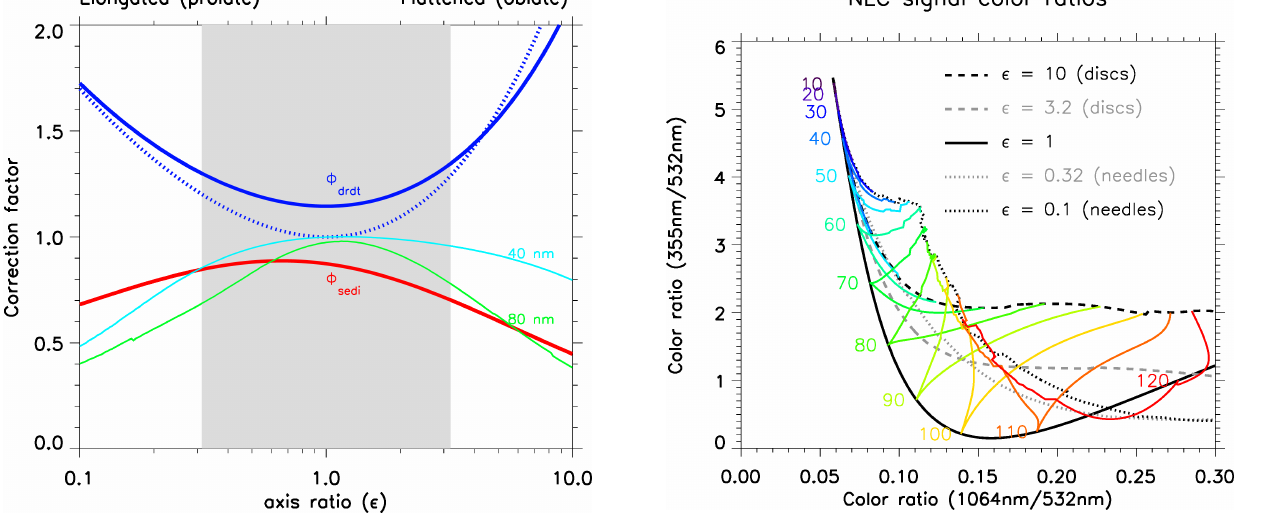
Figure 2. Correction factors (cid:56) d r d t for particle growth and (cid:56) sedi for sedimentation of cylinders relative to growth and sedimentation of spheres. The dotted blue line shows (cid:56) d r d t for spheroid parti- cle shape. Thin lines show the backscatter signal (532nm) ratio of same-volume cylinders to spheres for equivalent radii of 40 and 80nm. Shading indicates the ε limits of moderately elongated or flattened particles consistent with satellite measurements (Hervig and Gordley, 2010).